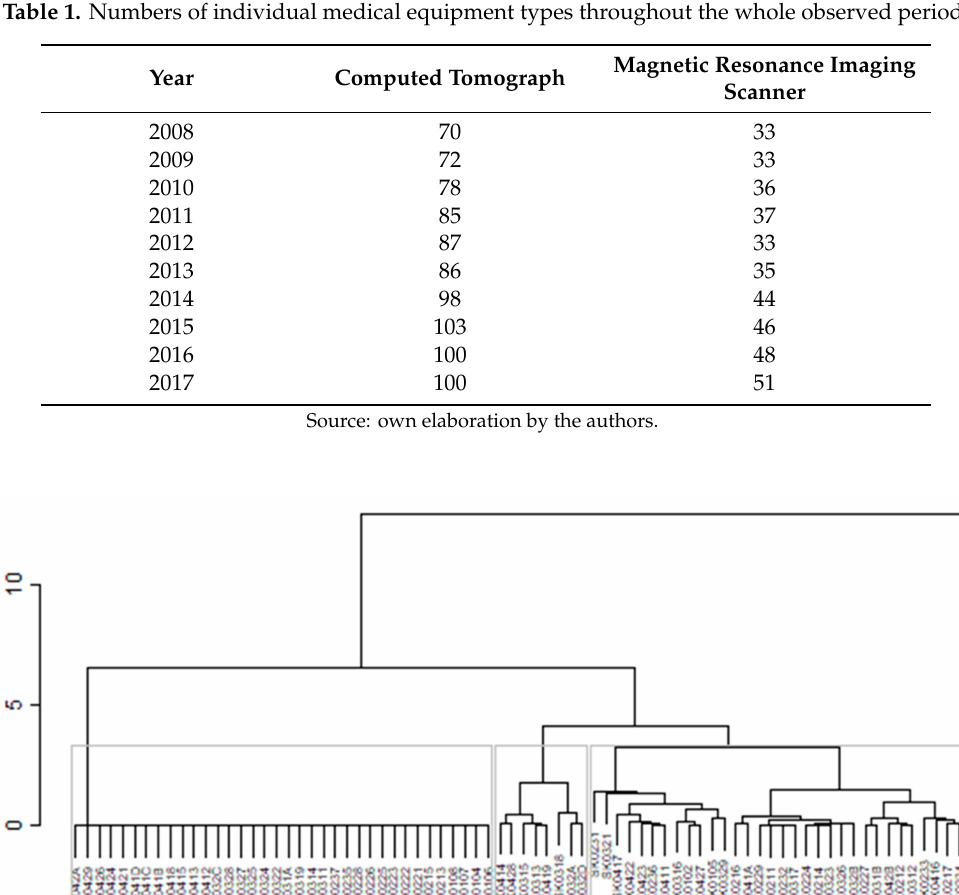
Table 1. Numbers of individual medical equipment types throughout the whole observed period.